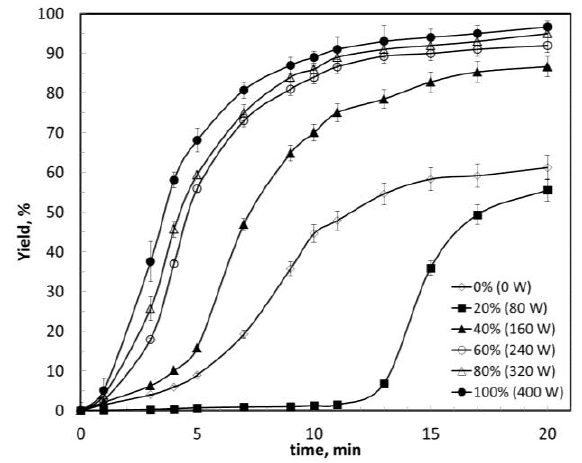
Figure 3. Effect of ultrasound power on the extent of conversion (MeOH:Oil 9:1, 0.7% KOH).